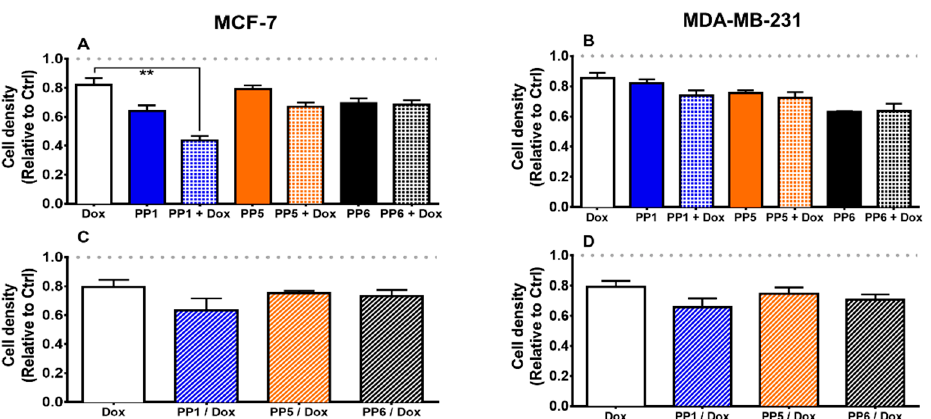
Figure 5. PP1 in combination with a sub-cytotoxic dose of doxorubicin reduces cell survival. MCF-7 ( A and C ) and MDA-MB-231 ( B and D ) cells were seeded in 96-well plates in complete media. Twenty-four hours later, the media were replaced with 1% FBS containing 100 µM PhytoPs (PP1, PP5, or PP6) and a sub-cytotoxic dose of doxorubicin (20 nM, Dox) for 48 h. At the end of the incubation, cells were submitted to a cell density assay. ( A and B ) Results of combined exposure for 48 h are shown. ( C and D ) These panels show results after pre-incubation with PhytoPs for 48 h and media replacement with media containing 20 nM doxorubicin for an additional 48 h. Cell density was later determined with crystal violet stain. The control group (Ctrl) was incubated with vehicle alone. All treatment values were normalized against Ctrl values. The following symbol denotes a statistical significance when compared to the control group: * p < 0.05. Importantly, we found that a dose of 20 nM of doxorubicin was associated with a 90% cellular survival, and this concentration was therefore chosen as sub-cytotoxic.